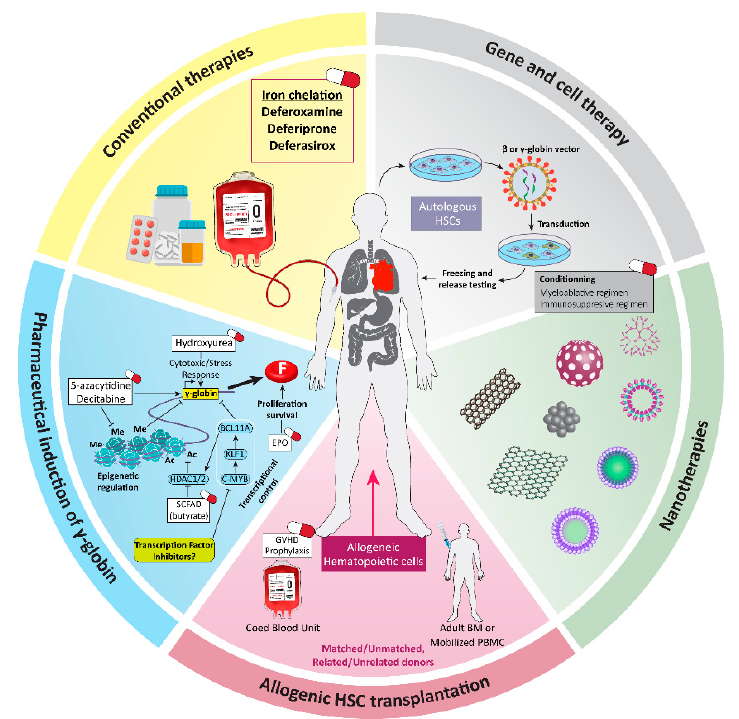
Figure 1. Current and future therapeutic approaches for β -thalassemia major. Among the various kinds of treatments used for treatment of β -thalassemia patients, nanomedicine and gene therapy are the new emerging ones and have provided new hope in treatment of patients. Their application does not require